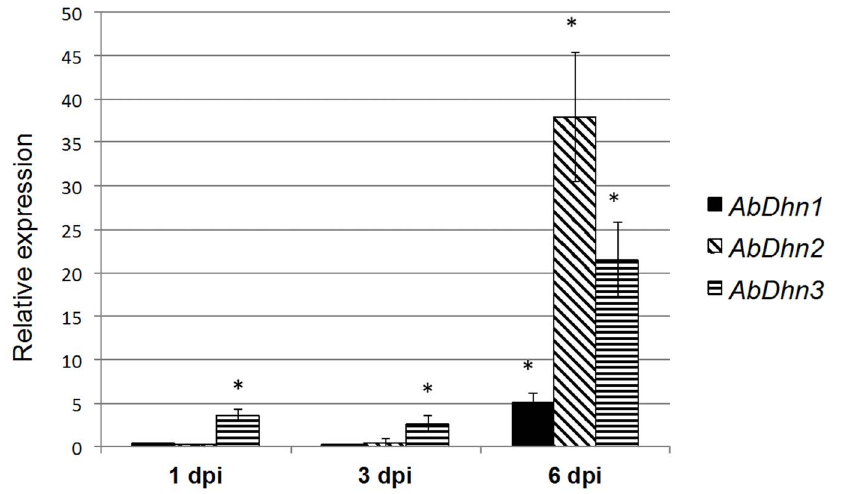
Figure 10. Quantitative RT-PCR results for the expression of AbDhn genes during the infection kinetics of A.brassicicola wild-type strain on B.oleracea . For each gene, expression induction is represented as a ratio of its relative expression at 1, 3 and 6 dpi (studied gene transcript abundance/tubulin transcript abundance) in each inoculated sample to its relative expression in free-living fungal control cultures. The experiment was performed twice on biologically independent samples with three technical replicates. Error bars indicate standard deviations and asterisks indicate a relative expression significantly different from 1 (Student test, P , 0.01).